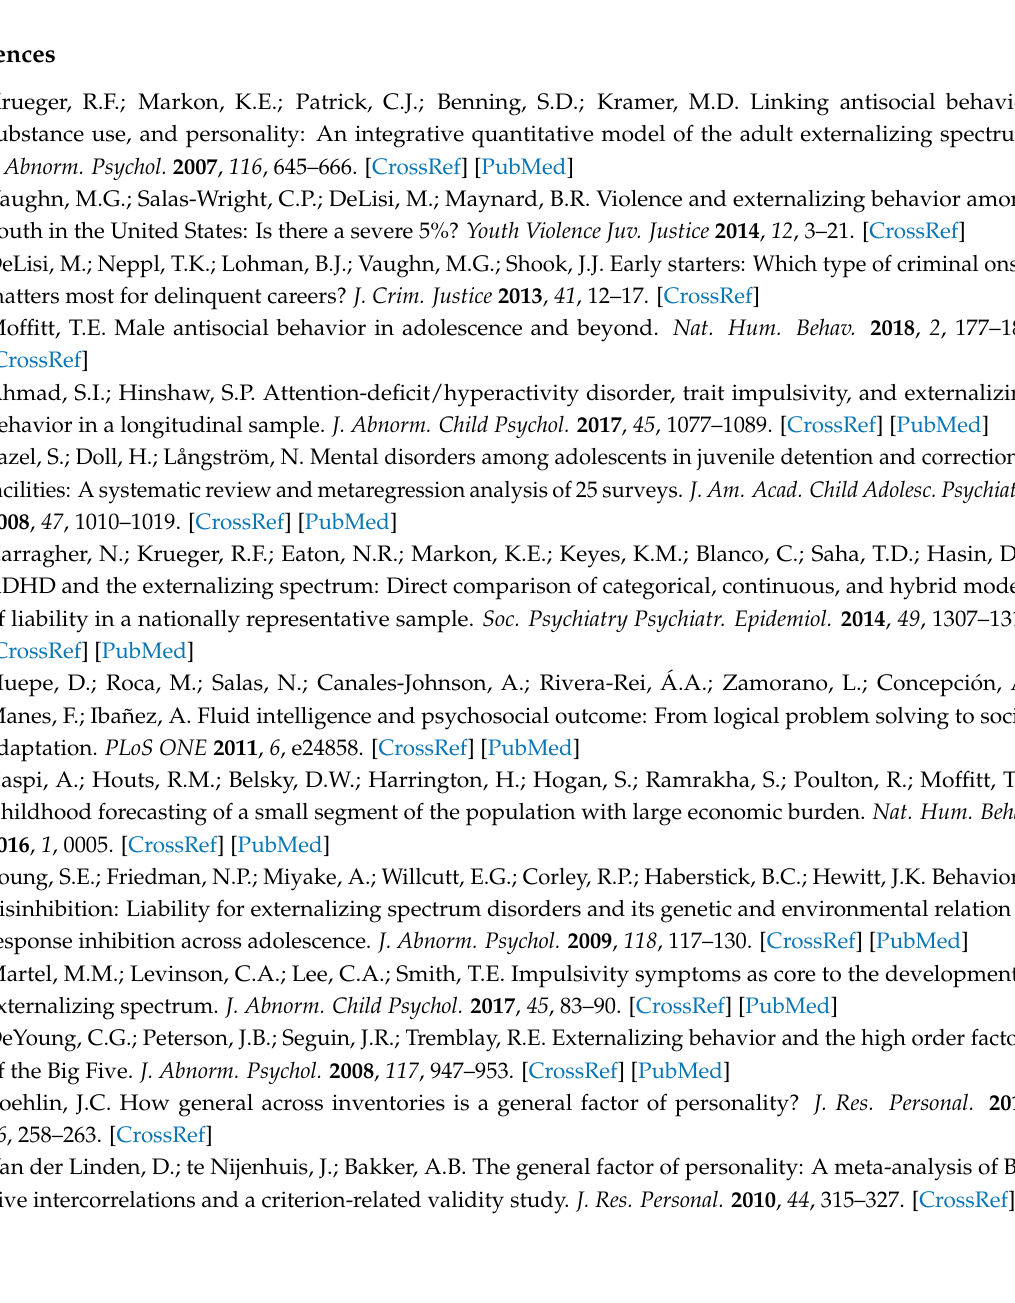
Table S1: Descriptive statistics and correlation matrix (including all the variables considered in the study); Table S2: EFA results for each general factor considered in the study; Table S3: Correlations among the three ADHD subscales and the remaining general